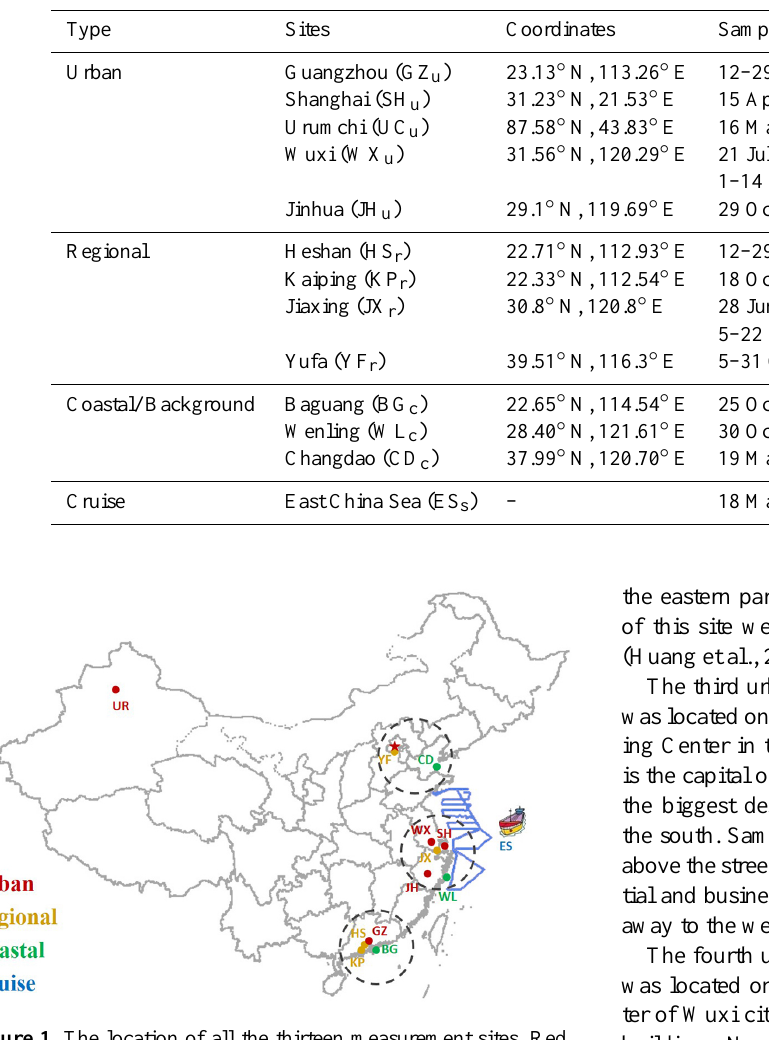
Figure 1. The location of all the thirteen measurement sites. Red, yellow and green color dots and blue line represent the sites types of urban, regional, costal and cruise. Black circles show the three largest urban areas in